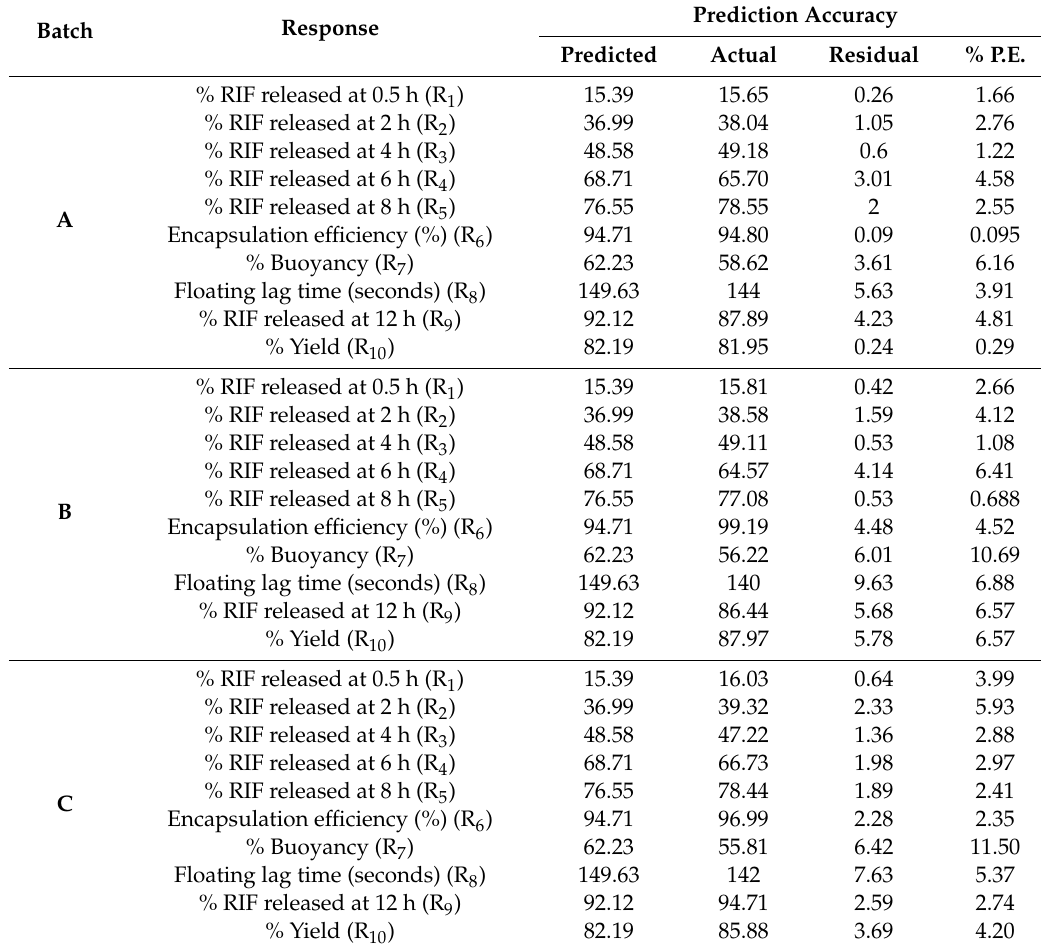
Table 11. Prediction accuracy for the Box Behnken design optimization